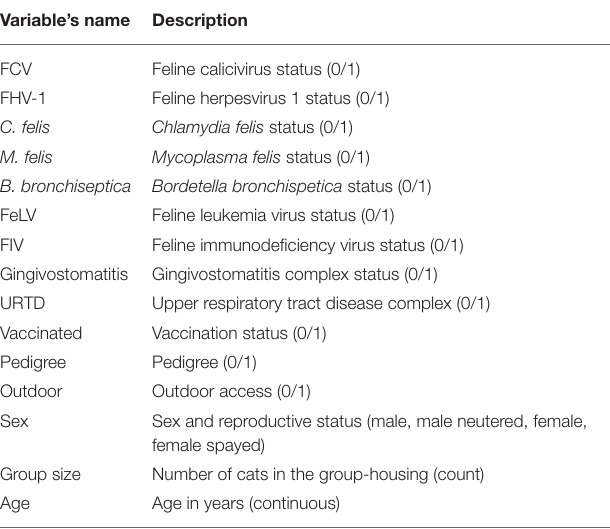
TABLE 1 | Description of the factors in the FCV